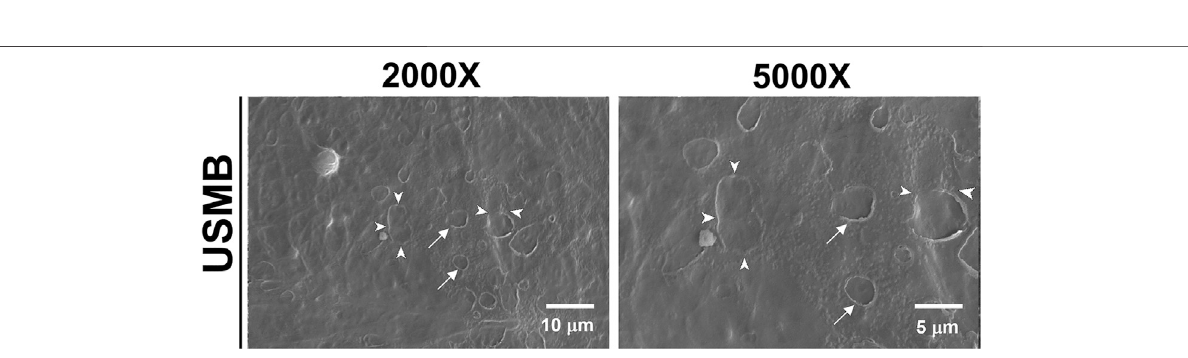
Frontiers in Pharmacology |